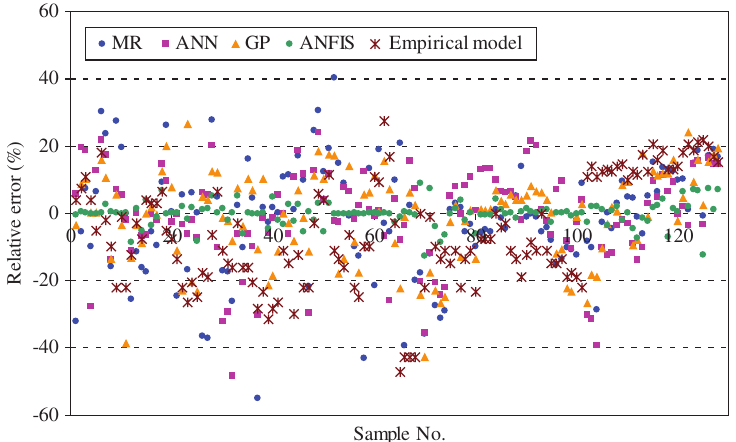
Figure 18 Relative errors (RE) of MR, ANN, GP, ANFIS, and empirical models.